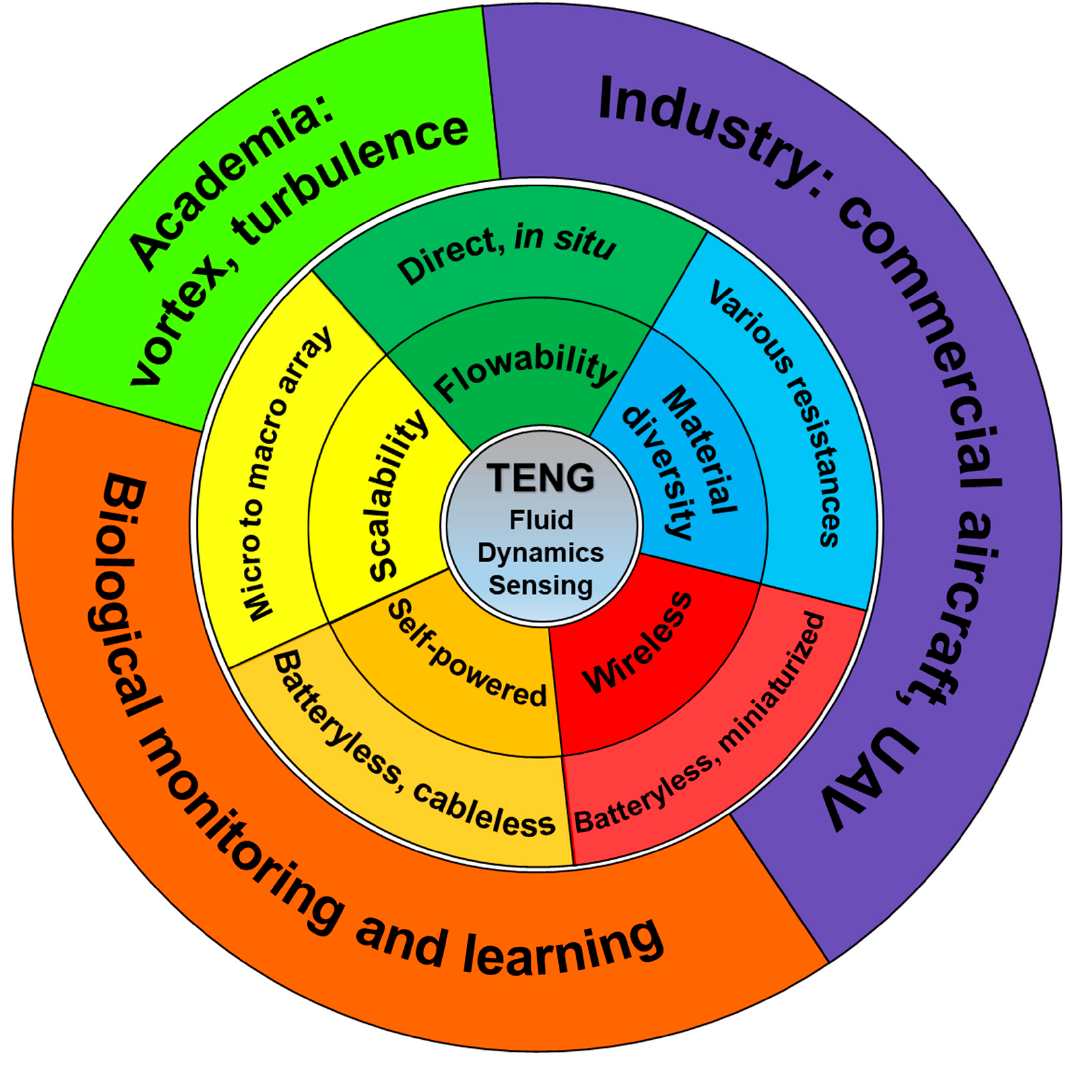
Figure 12. Schematics of advantages and future applications of TENGs for fluid dynamics